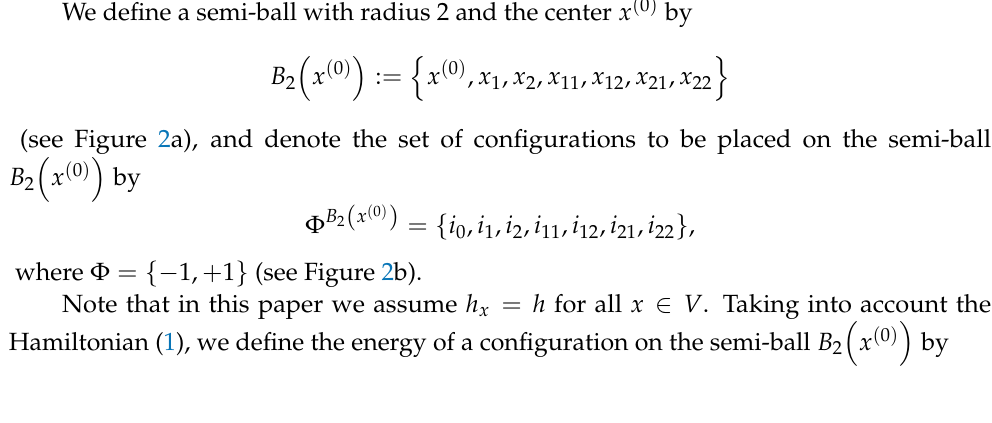
(cid:16) (cid:17) x ( 0 ) given on the